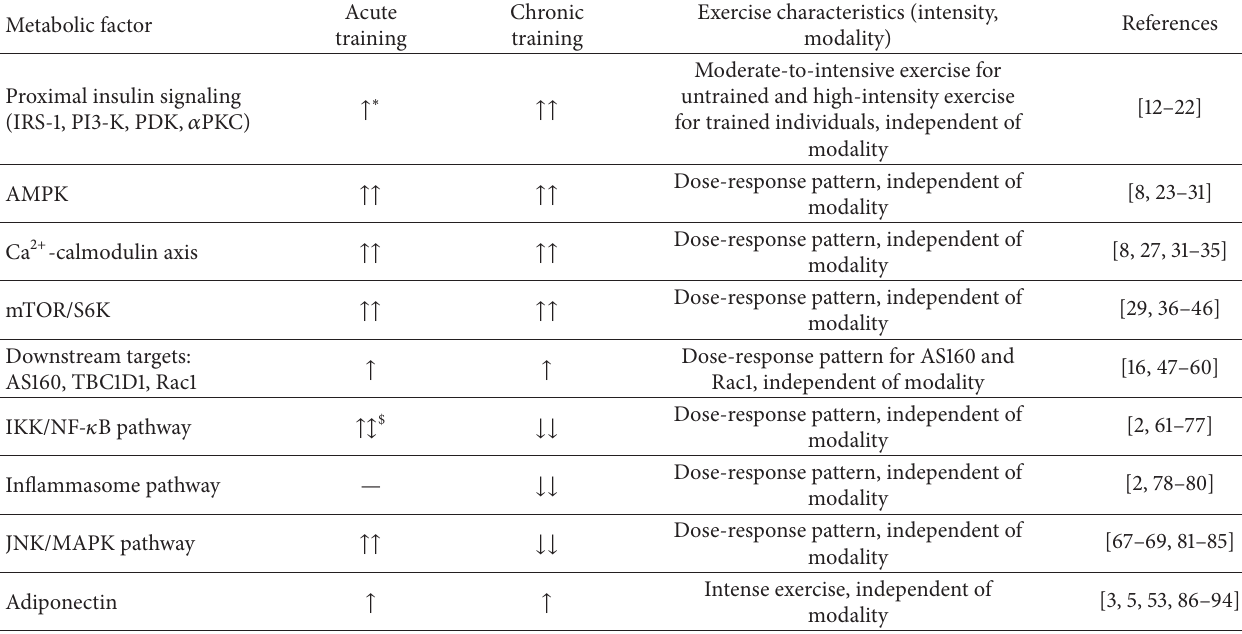
Table 1: Effect of acute and chronic exercise on molecular signaling